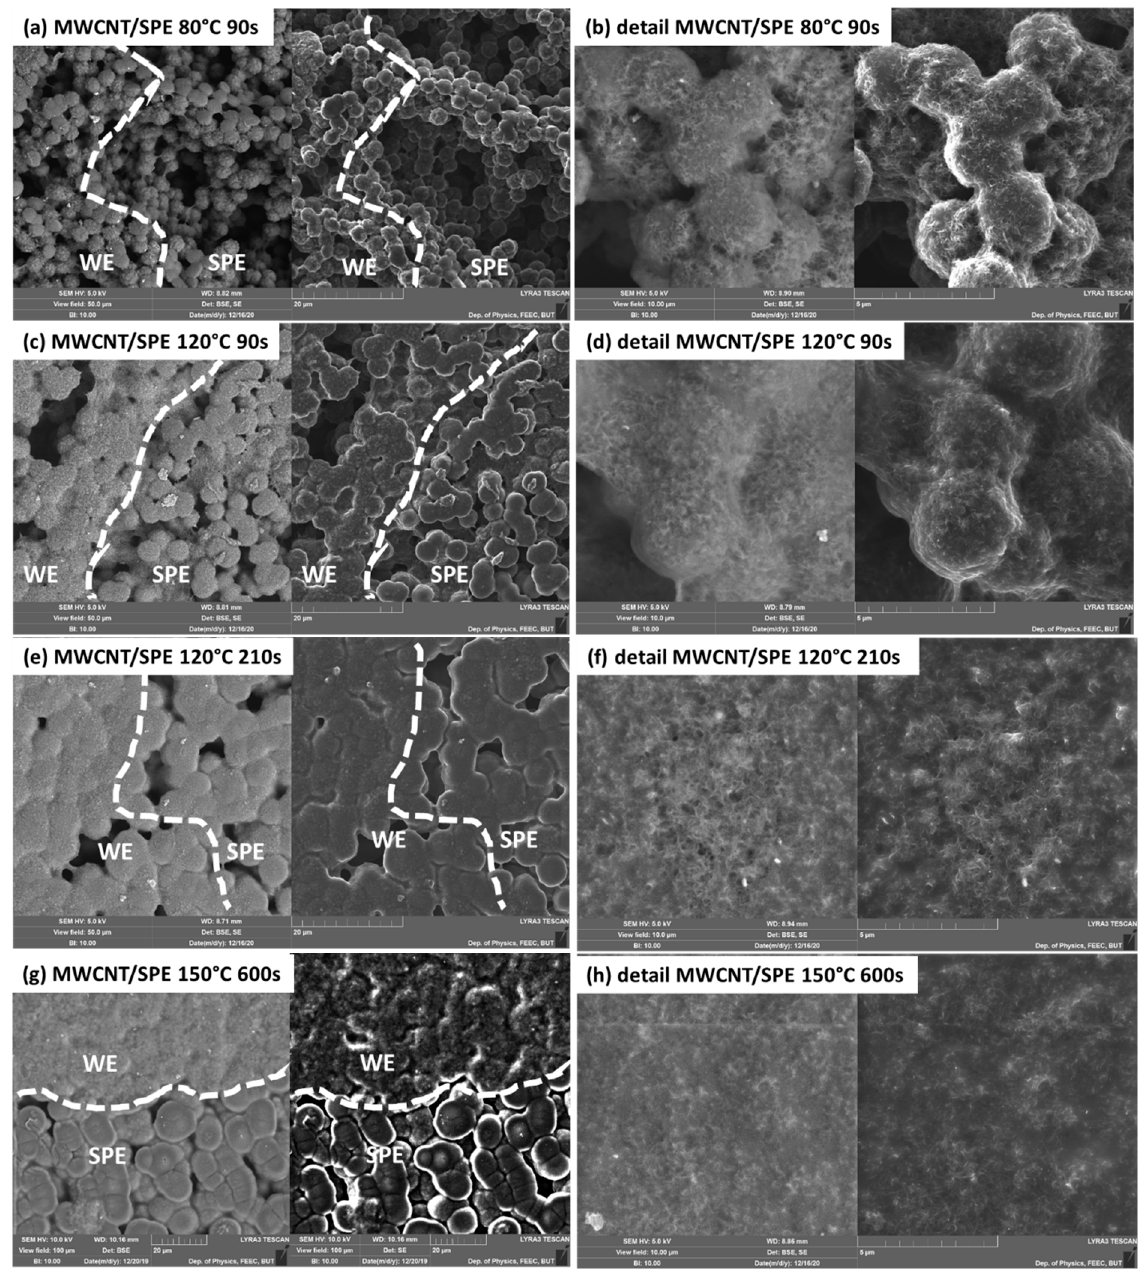
Figure 2. SEM images (back-scattered electron imaging and secondary electron imaging) of the MWCNT WE–SPE interface with the [EMIM][TFSI] ionic liquid prepared for 90 s at 80 °C ( a , b ), 90 s at 120 °C ( c , d ), 210 s at 120 °C ( e , f ) and 600 s at 150 °C ( g , h ) with view-field 100 µm ( a , c , e , g ). The boundary lines of WE–SPE are estimated and plotted as dashed lines. ( b , d , f , h ) show details of WE electrodes on SPE layers of corresponding crystallinities with view-field 10 µm.